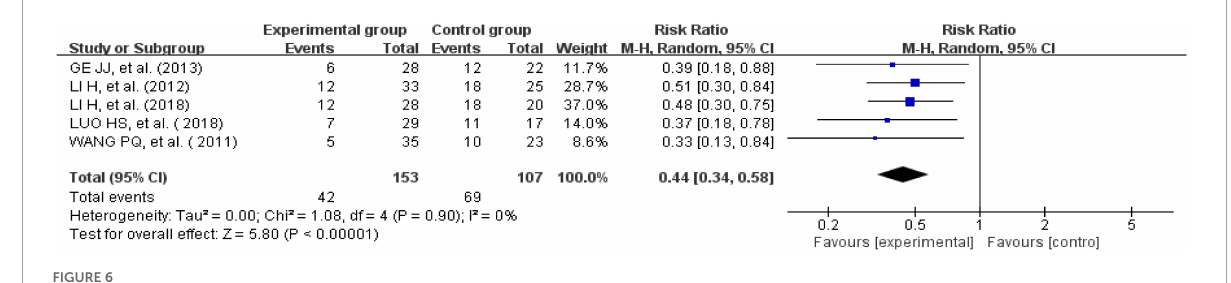
FIGURE6 Forest plot of the recurrence rate.